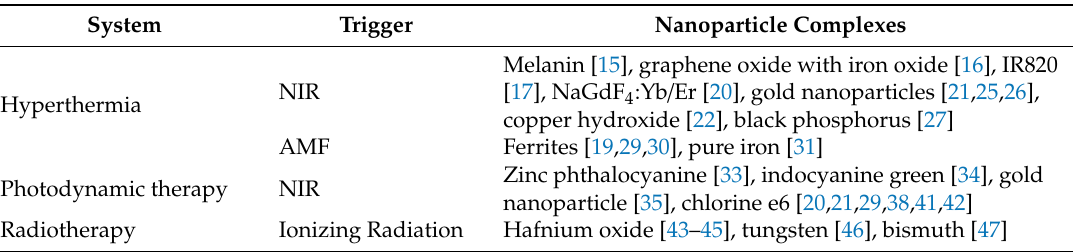
Table 1. Externally activated nanoparticle